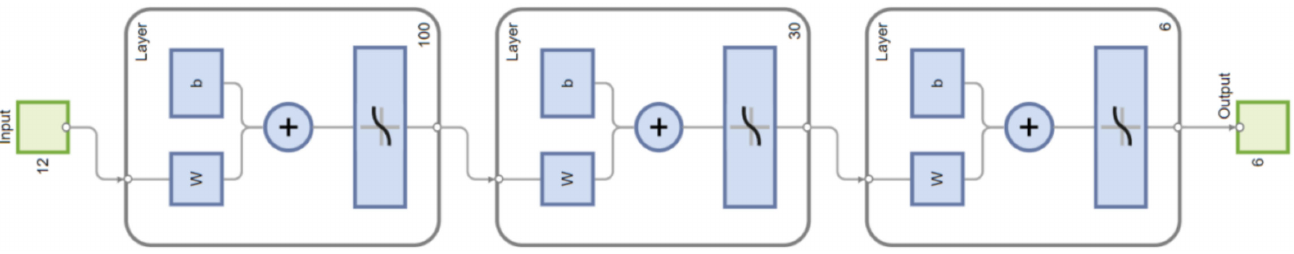
Figure 11. Best maximized desirable topology used in this